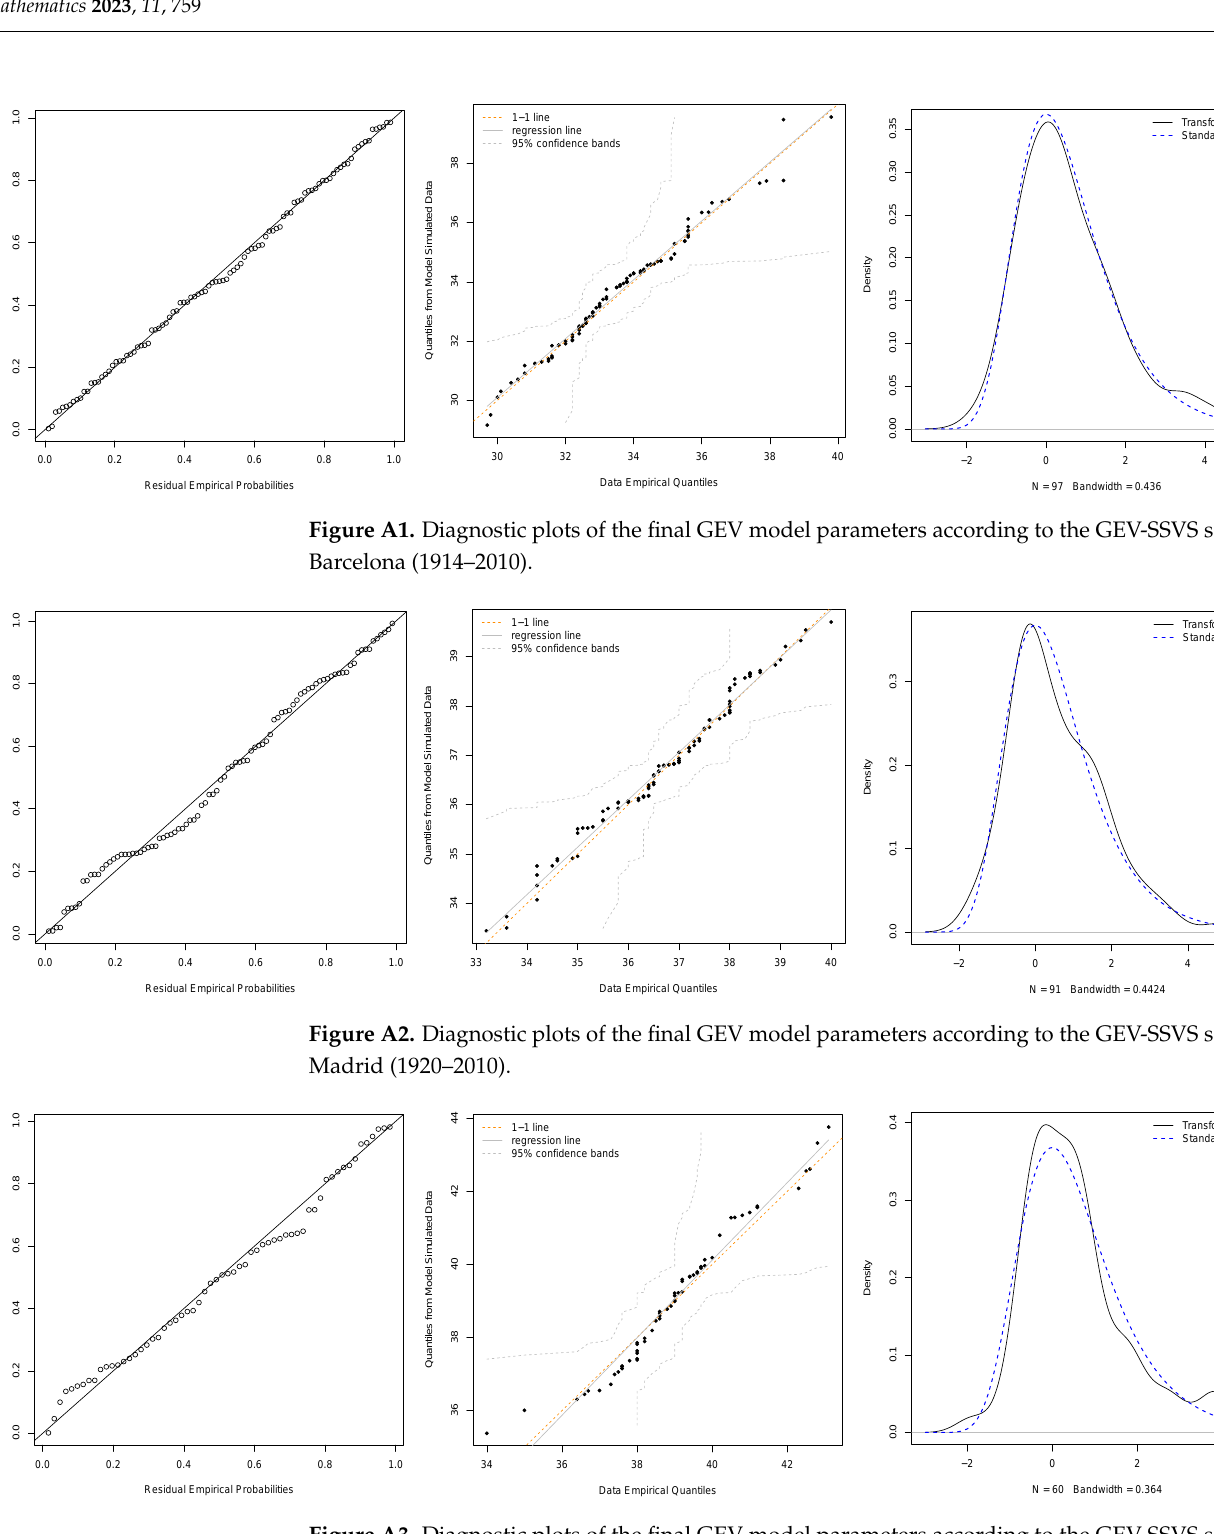
Figure A3. Diagnostic plots of the final GEV model parameters according to the GEV-SSVS selection. Zaragoza